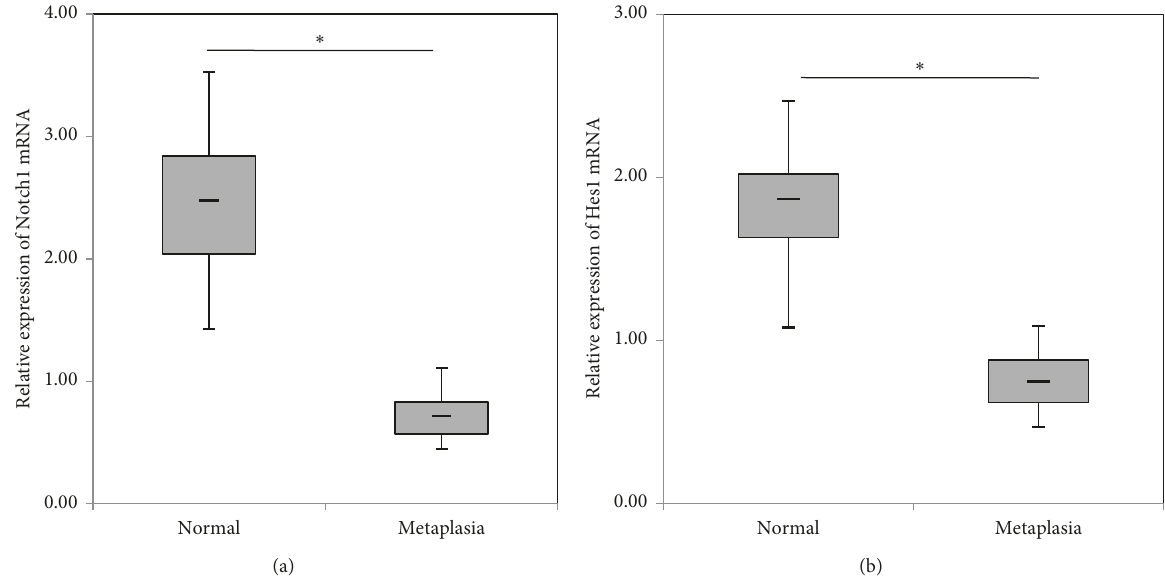
Figure 3: Relative expression of Notch1 (a) and Hes1 (b) mRNA in normal esophagus and metaplastic esophagus. Significant differences were detected in Notch1 mRNA and Hes1 mRNA expression values between normal squamous mucosa and metaplastic tissue. ∗ 𝑝 < 0.05 , statistically significant